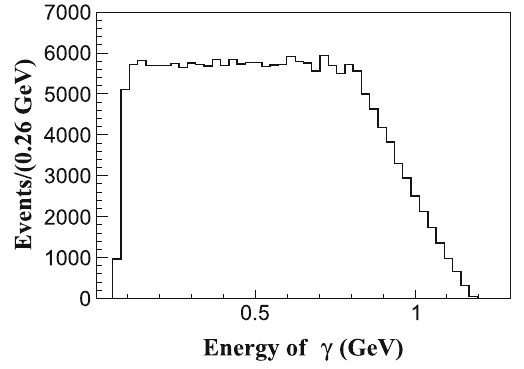
Fig. 5 The energy of γ from Monte Carlo simulation, which is from e + e − → D + s D − s , D + s → μ + ν μ , D − s → η γγ π −